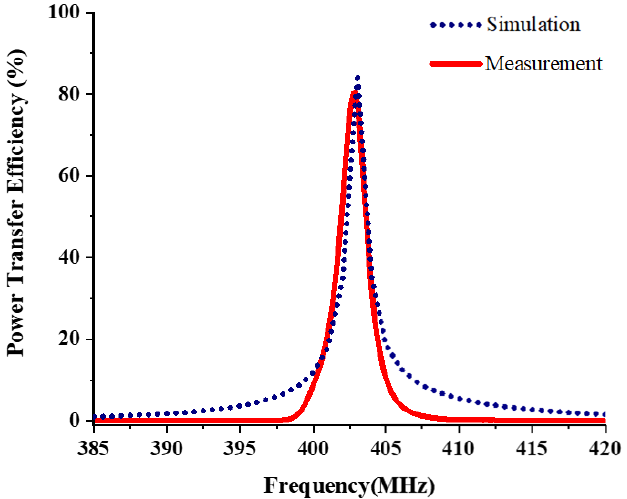
Figure 14. Comparisons of simulated and measured PTE against frequency.